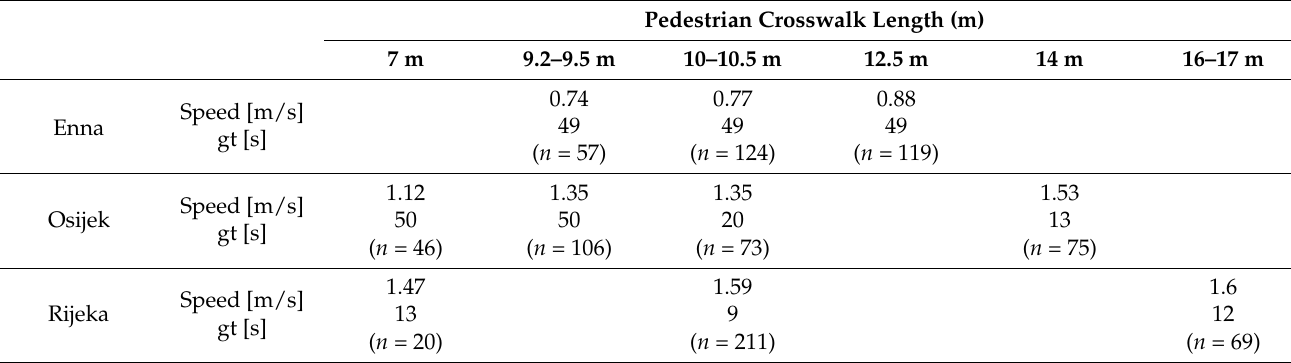
Table 8. Mean children’s pedestrian speed–depending on crosswalk